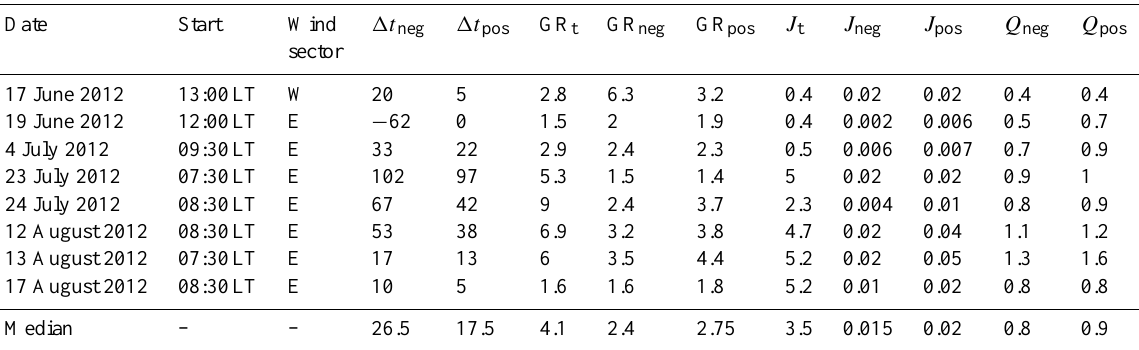
Figure 3. Median diurnal variation of cluster ion concentrations (diameter <1.6 nm) during 8 selected NPF event days (a, c) and 13 non-event days (b, d) , as measured with the NAIS during summer 2012 at the Waldstein site. The shaded areas denote the 25th and 75th percentile. Table 2. Event features of all 8 selected NPF events used for this study. Shown are the following: NPF event start time (CET), prevailing wind direction, time difference 1t of 2–3nm ions [min.], growth rates GR of 2–3nm total particles and ions [nm h − 1 ], formation rates J of 2–3nm total particles and ions [cm − 3 s − 1 ] and ionization rates Q for cluster ions [cm − 3 s − 1 ]. Values for Q neg , Q pos , J neg and J pos are probably underestimated, please refer to Sect. 3.2 for